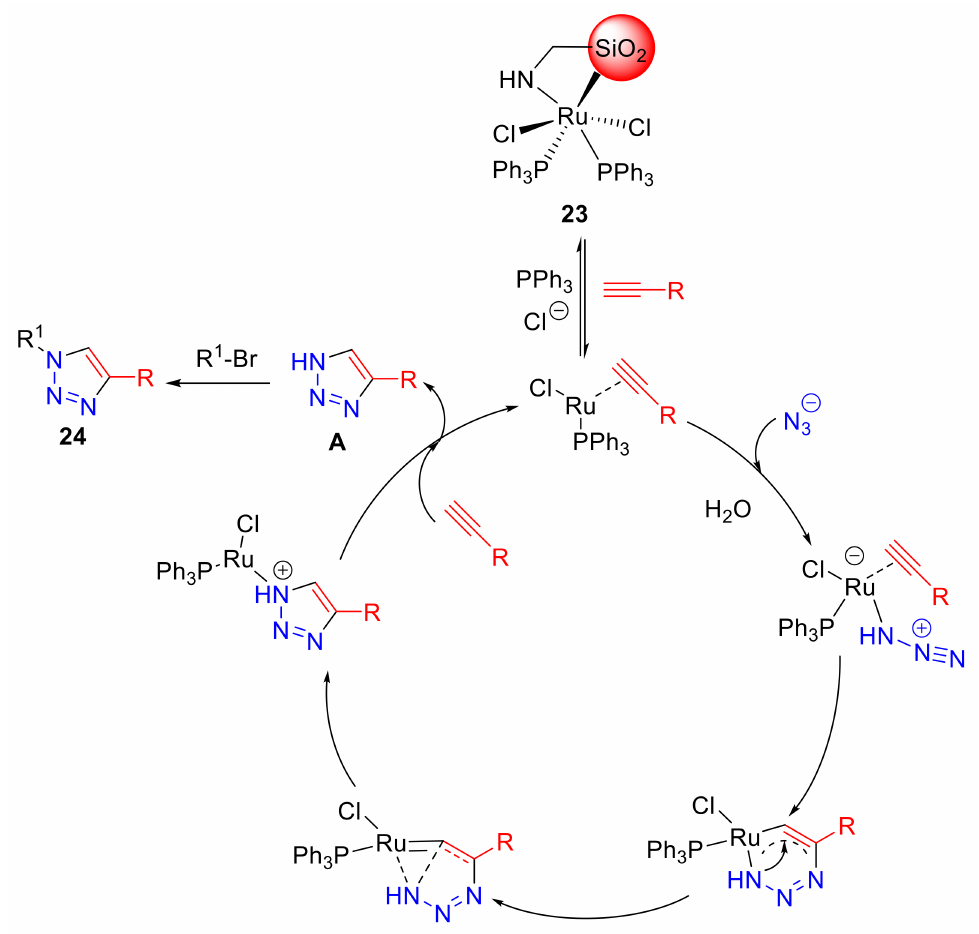
Scheme 9. Plausible mechanism for the click reaction catalyzed by